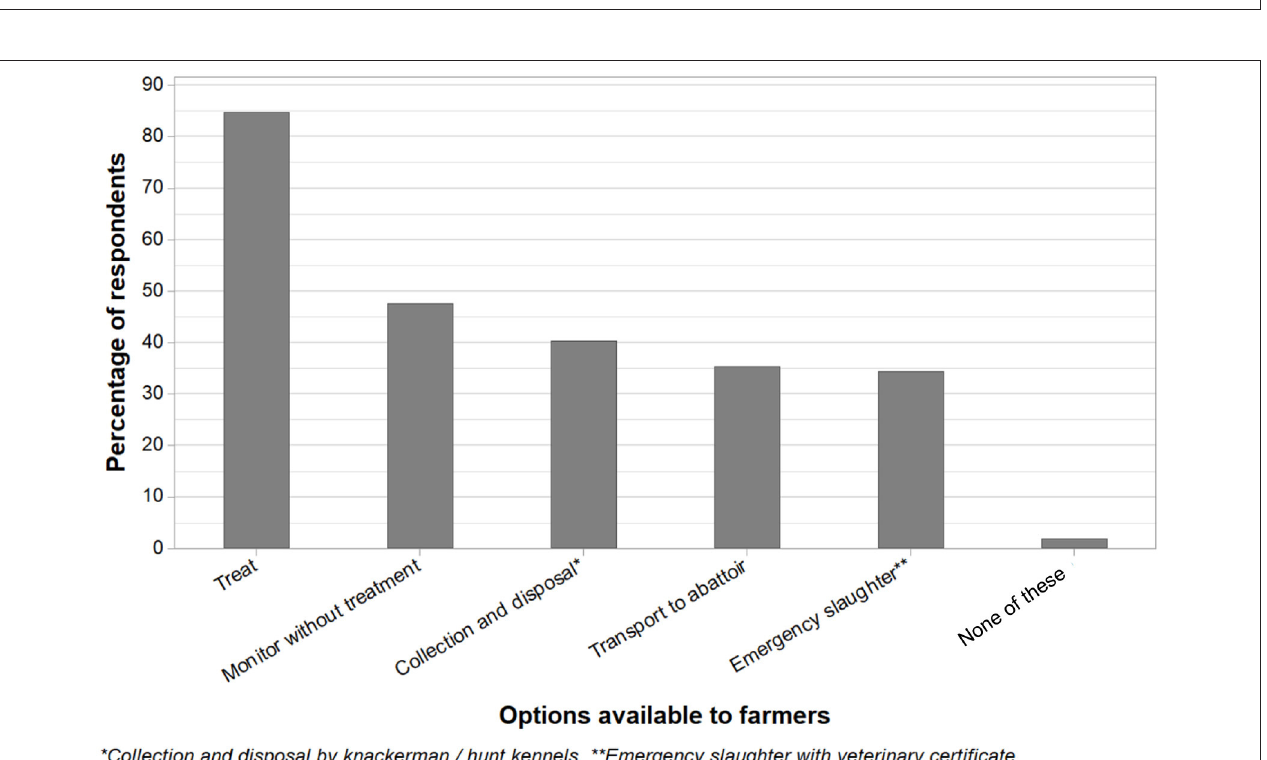
FIGURE 9 | Farmer self-reported options available to them to deal with animals that have ongoing lameness, as a percentage of respondents. Farmers could select multiple answers [except if they select “None” (Q10, n = 501)].